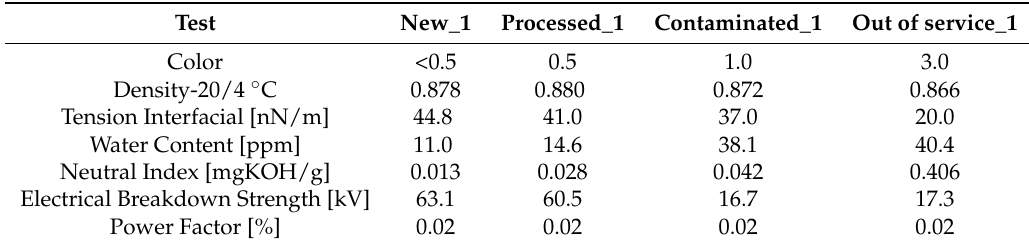
Table 2. Physical-chemical analysis of Database